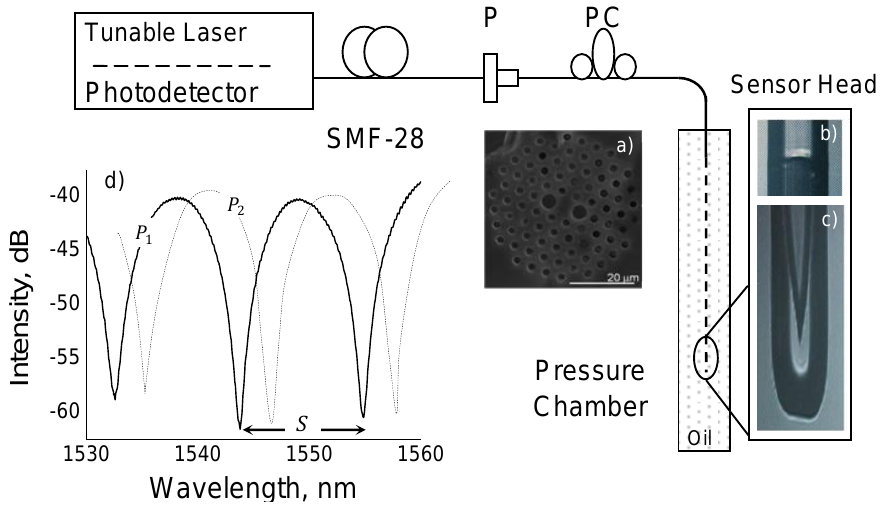
Figure 4. Sensor setup. SMF28: standard single mode fiber; P: polarizer; PC: polarization controller. Insets: (a) HiBi fiber cross section; (b) Optical image of the splice between the PCF and the standard fiber and (c) fiber end-cap; (d) Broadband interference spectrum indicating the space 𝑆 between two